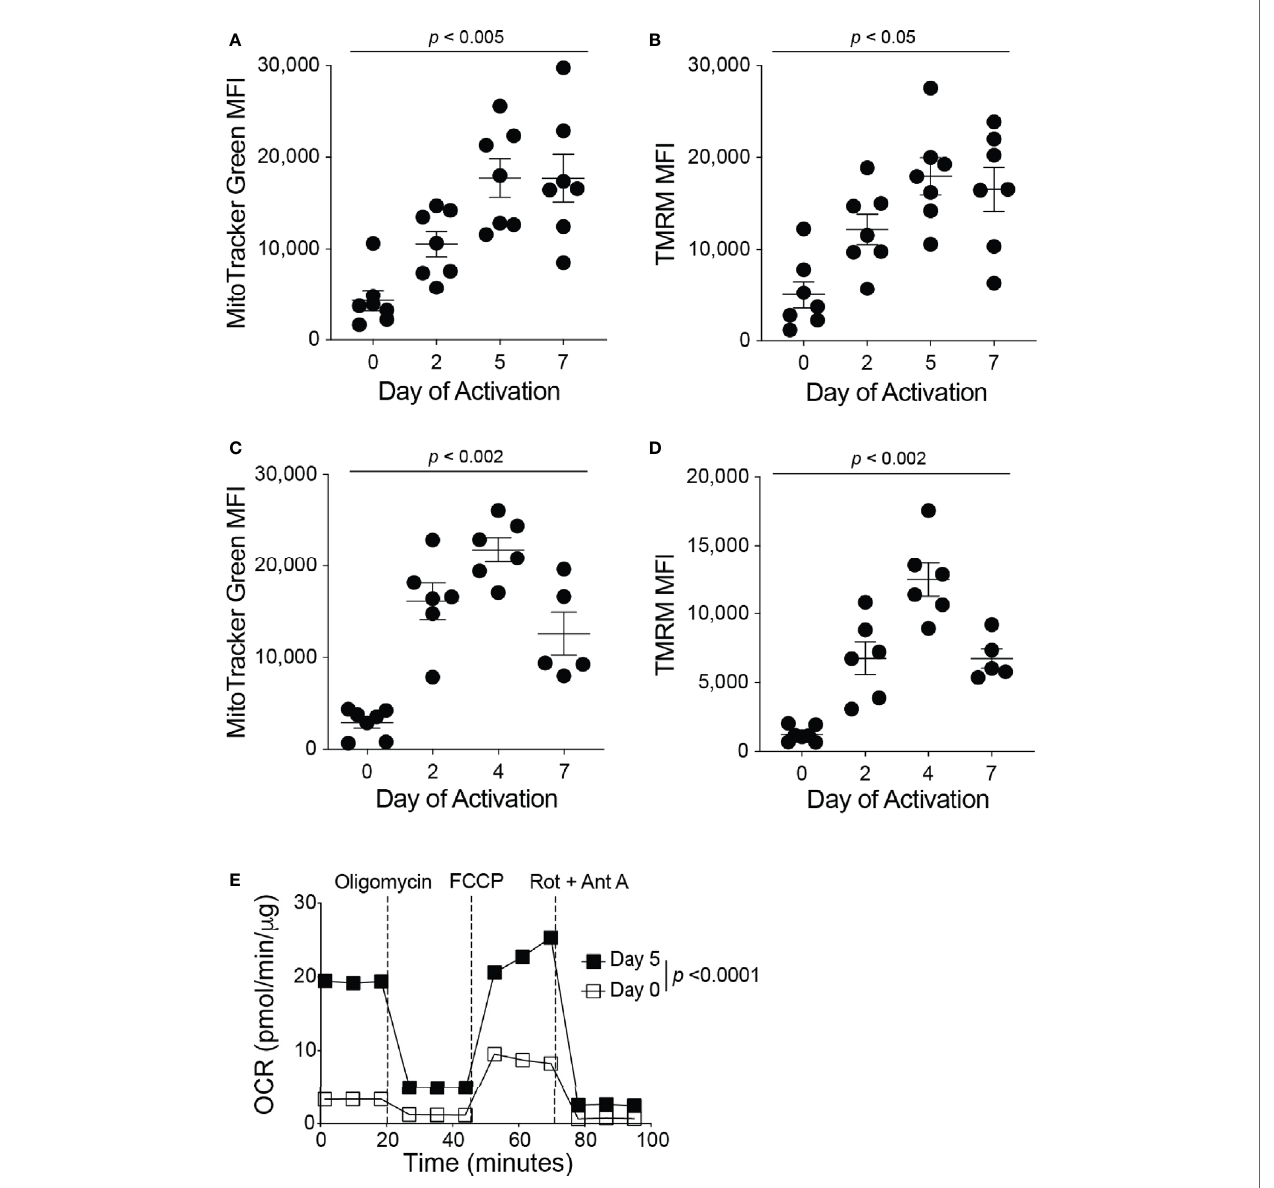
FIGURE 1 | Mitochondrial function increases during CD8 + T cell activation. Flow cytometry analysis of (A) MitoTracker Green FM, re fl ecting mitochondrial mass, and (B) Tetramethylrhodamine (TMRM), re fl ecting mitochondrial membrane potential, displayed as mean fl uorescence intensity (MFI) during human CD8 + T cell activation (n = 7 donors). Flow cytometry analysis of (C) MitoTracker Green FM and (D) TMRM shown in MFI during mouse CD8 + T cell activation (n = 5-7 mice). (E) The oxygen consumption rate (OCR), measured with the Seahorse MitoStress Test, of naïve (Day 0, PLL + CCL21 coated wells) and activated (Day 5, PLL + CXCL12 coated wells) CD8 + T cells, normalized to protein content with a BCA assay; data shown as mean ± SEM (Representative of two independent experiments, n = 10 wells per group, error bars fall within symbols). All data shown as mean ± SEM. (A, B) Repeated measures one-way ANOVA with Bonferroni ’ s post-test. (C, D) Ordinary one-way ANOVA with Bonferroni ’ s post-test. (E) 2way ANOVA with Bonferroni ’ s